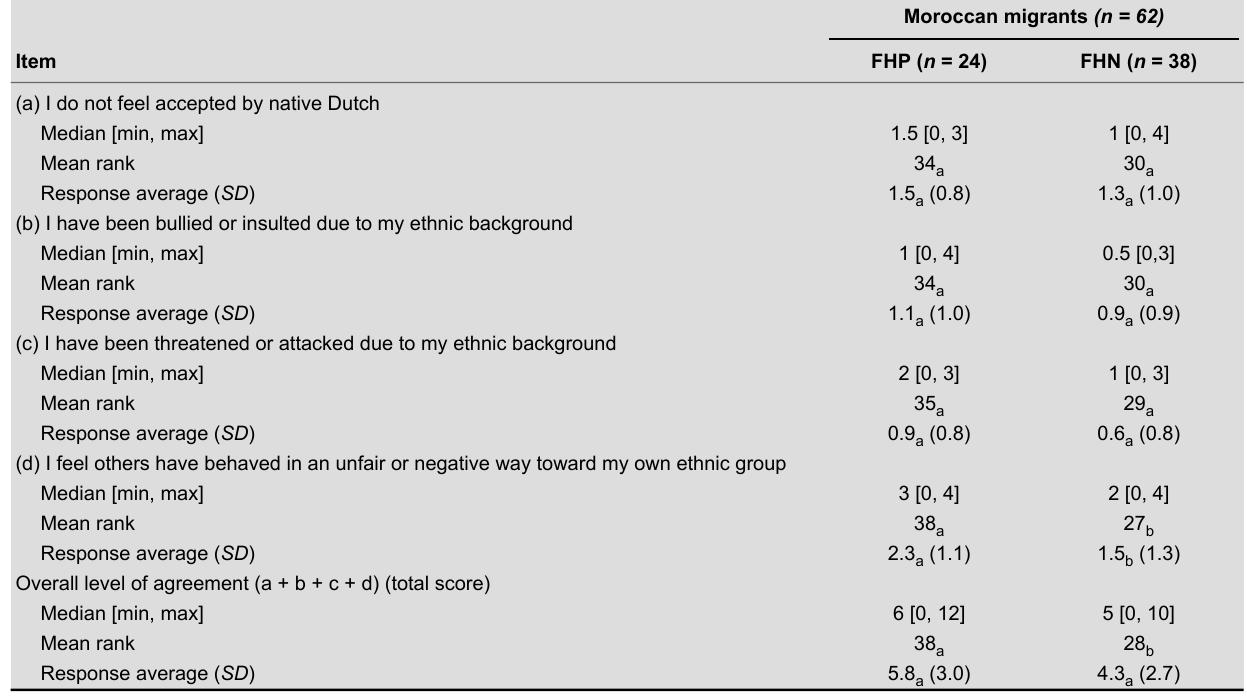
Perceived Discrimination as a Function of Family